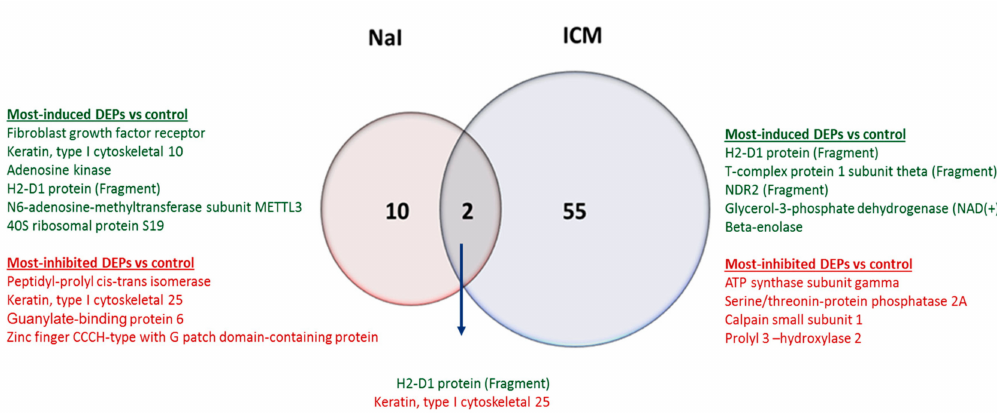
Figure 4. Identification of the significant di ff erentially expressed proteins (DEPs) induced by NaI and ICM treatments. A Venn diagram illustrating the common and unique DEPs in the thyroid between NaI and ICM. The numbers represent the proportion of significantly changed proteins in each comparison with control thyroids.